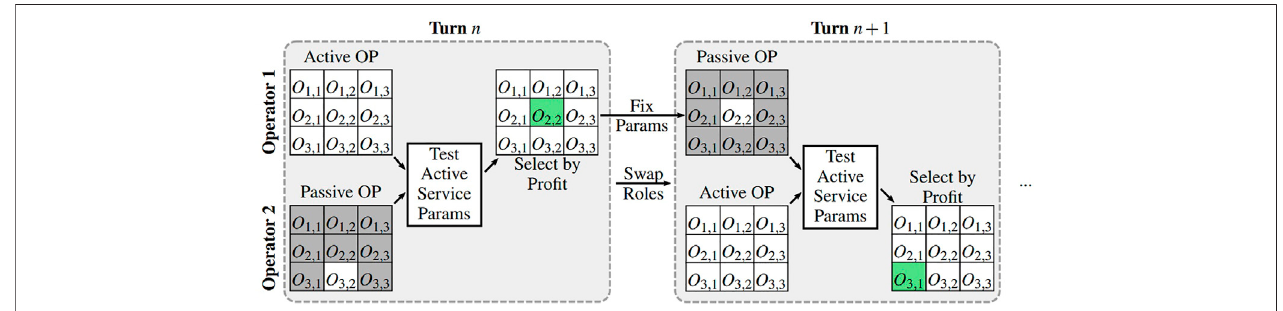
FIGURE 4 | Illustration of the game. Operators take turns playing the “ active ” role. In each turn, the active operator tests all of its possible service parameters O k , l against the passive operator ’ s fi xed parameters. The parameters that bring the highest effective pro fi t for the active operator are then used in the next turn, where the roles are